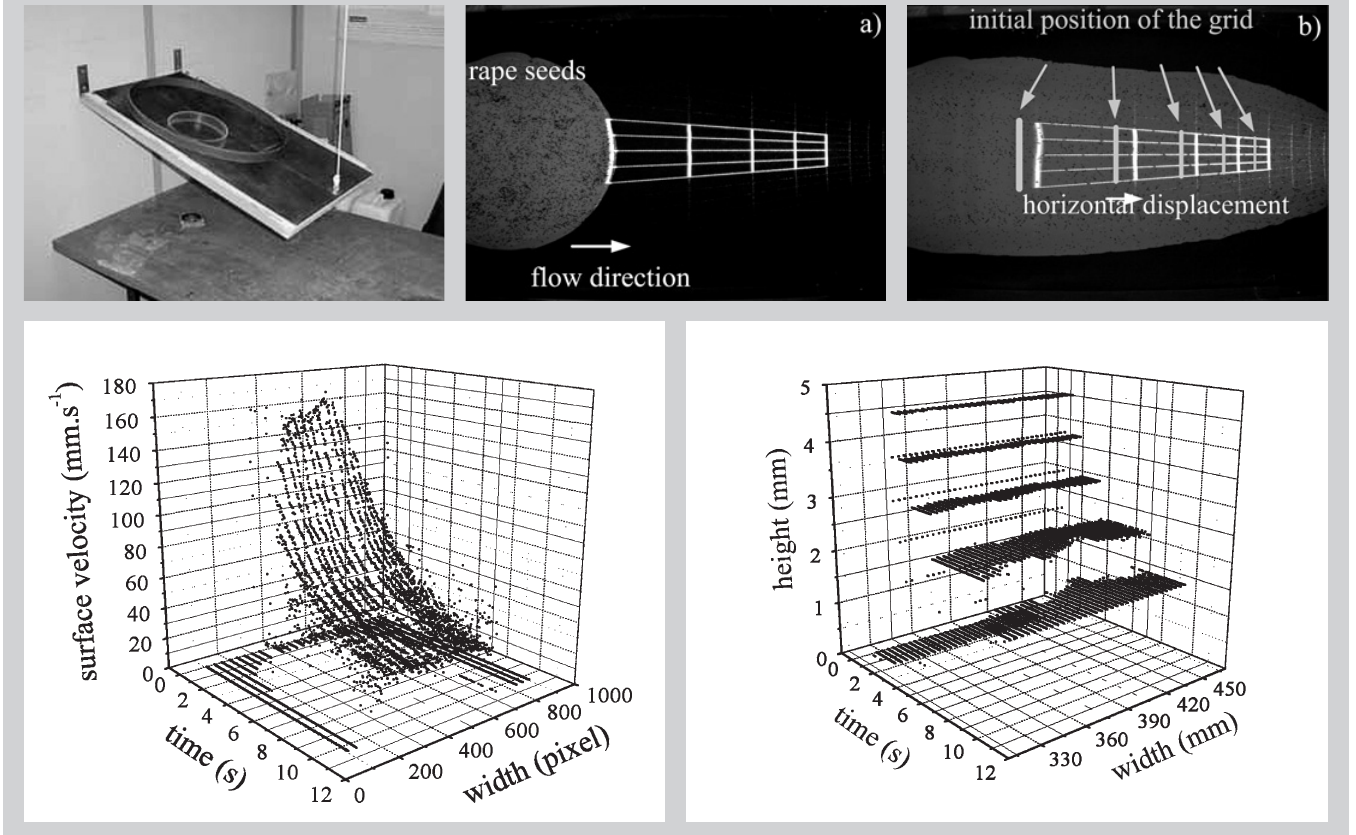
Figure 4 (left above): Inclined plane used for “static tests”. Figure 5 (middle and right above): Exemples of pictures record- ed with the movie camera and showing the laser grid deformations. a) Before flow. b) At the end of the flow. Figure 6 (left below): Dynamic tests: surface velocity at different dis- tances from the central line (width) as a function of time for a 30 s rest time and 12.9º slope angle. Figure 7 (right below): Dynamic tests: heights at different distances from the central line (width) as a function of time for a 30 s rest time and 12.9º slope